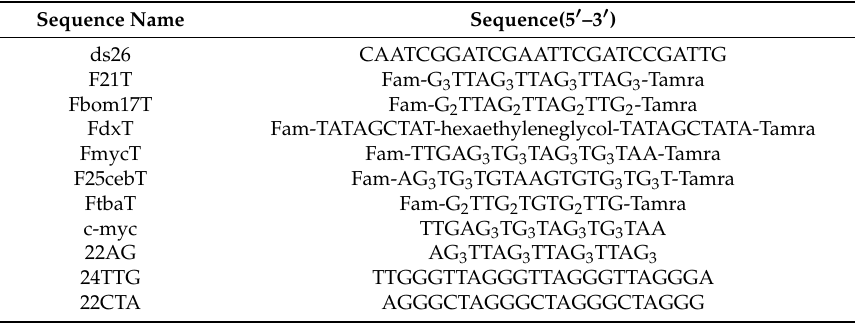
Table 5. List of DNA sequences used in the FRET